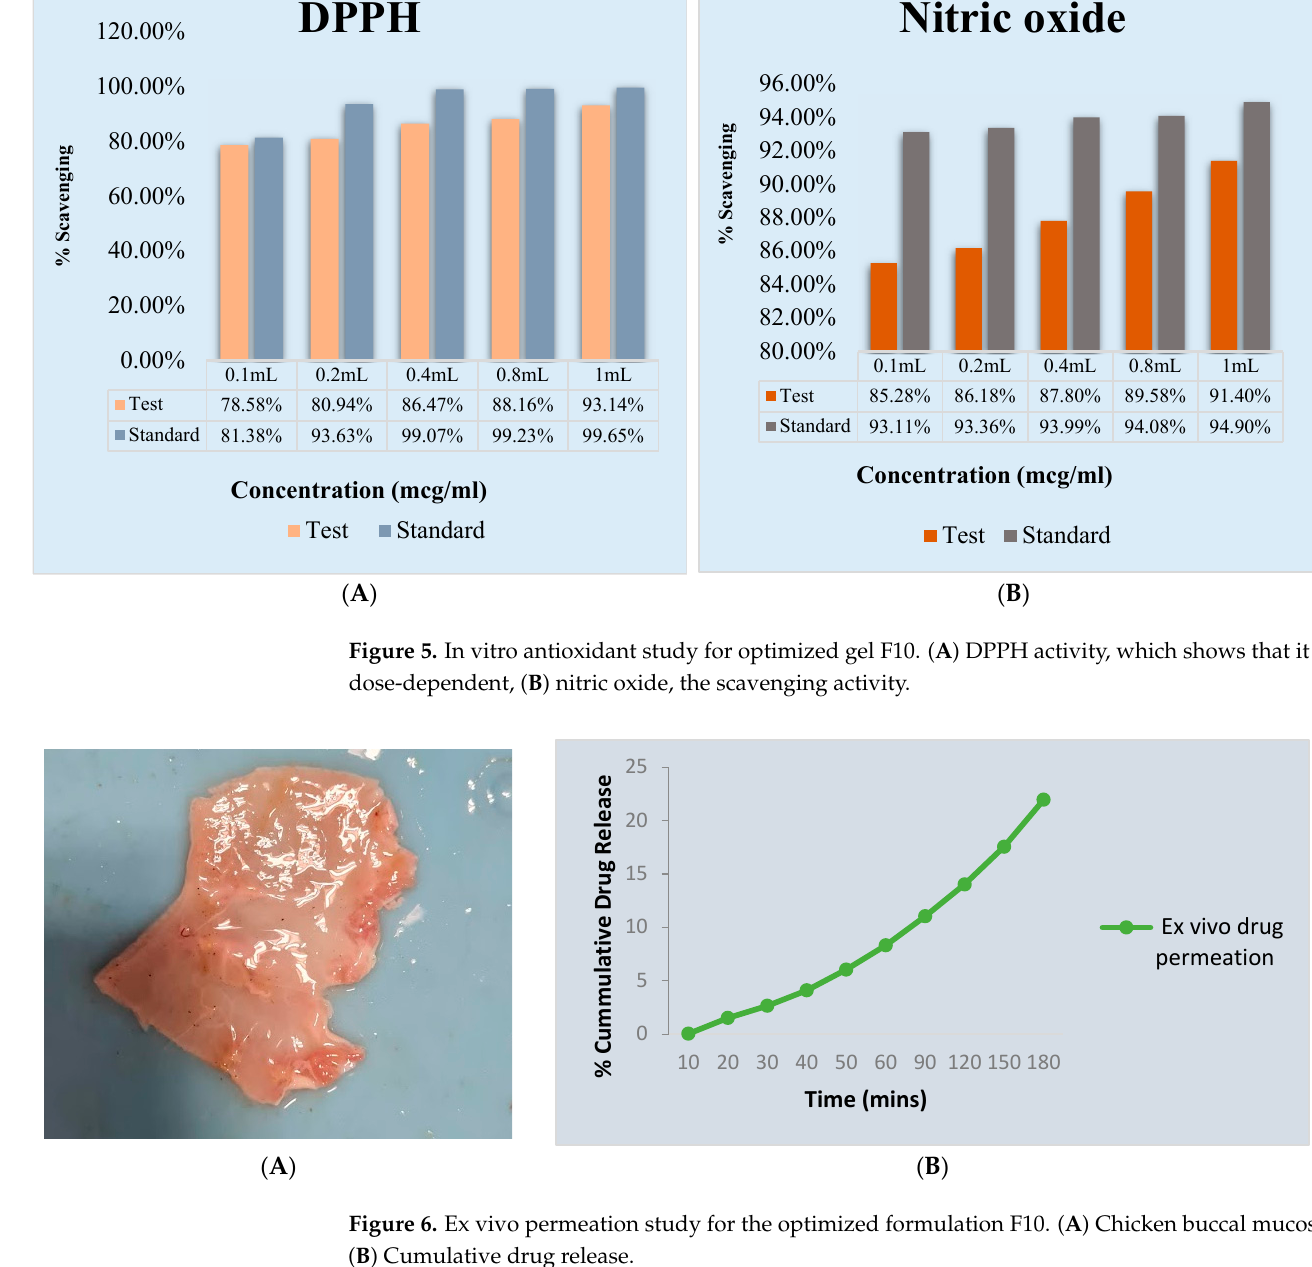
Figure 6. Ex vivo permeation study for the optimized formulation F10. ( A ) Chicken buccal mucosa, ( B ) Cumulative drug release.